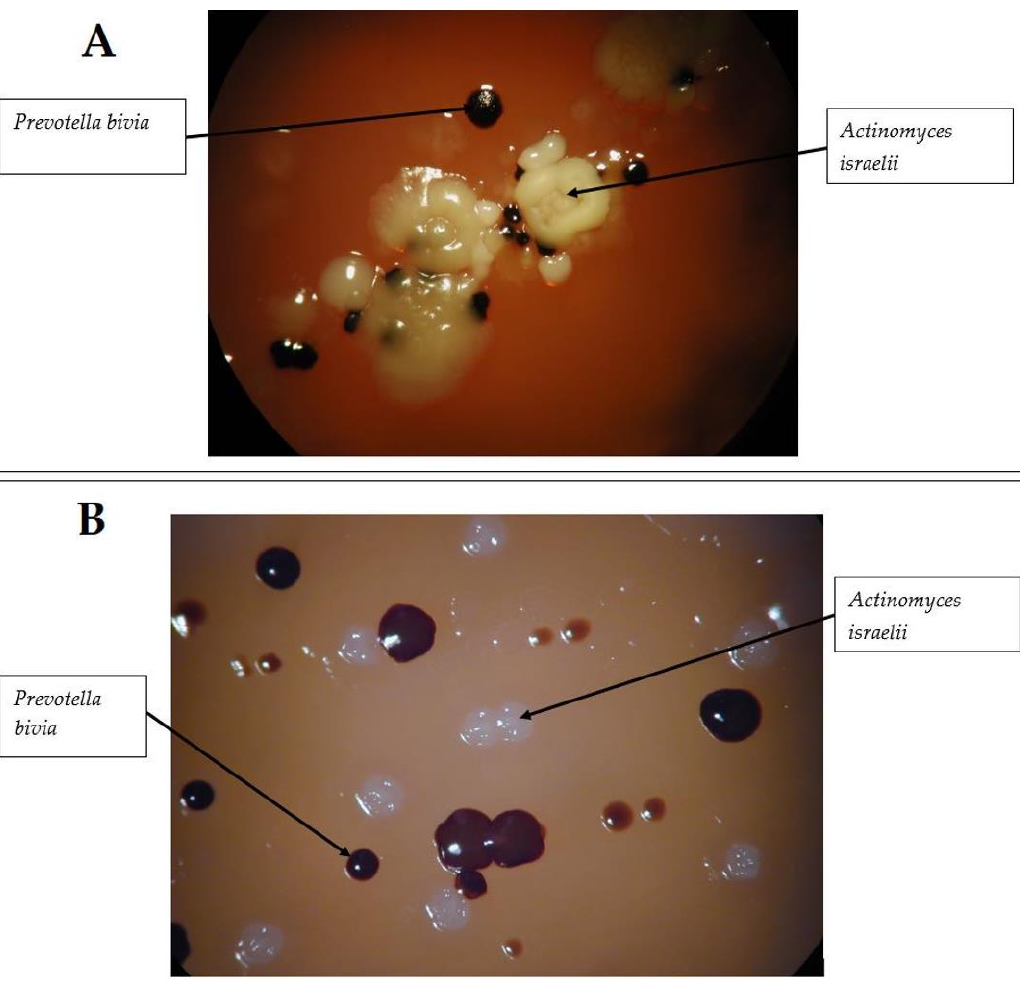
Figure 1. Culture results of the sample taken in Case 1. A: Colonies observed on anaerobic blood agar after 5 days of incubation B: Colonies observed on anaerobic blood agar after 7 days of incubation (courtesy of Gabriella Terhes PhD, University of Szeged) .